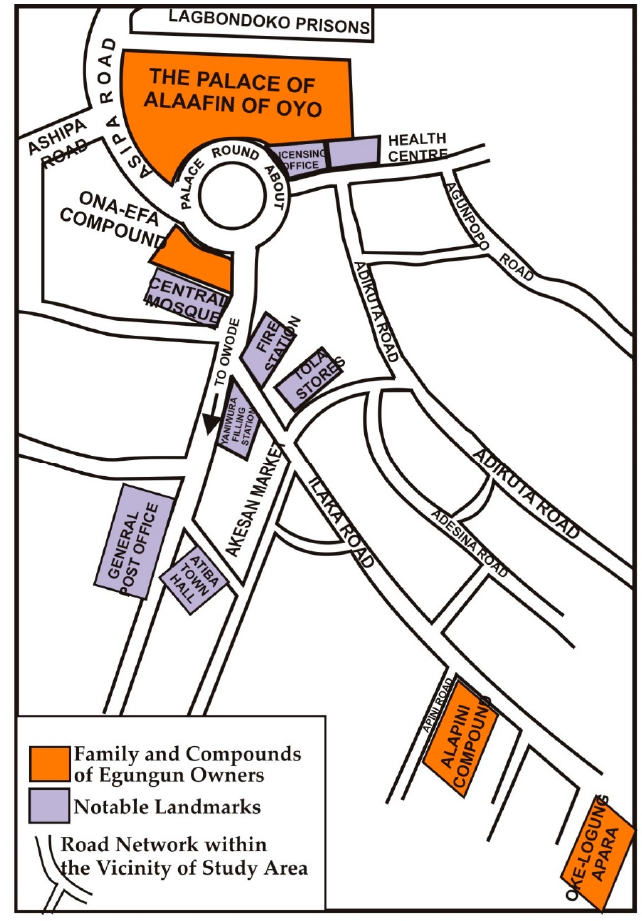
Figure 2. Map of Oyo Central District Showing Jenju (Alapini) and Mowuru (Ona-Efa) Family Compounds. Source: Ismail Hamzat, Cartography Section, Department of Geography, University of Ibadan,